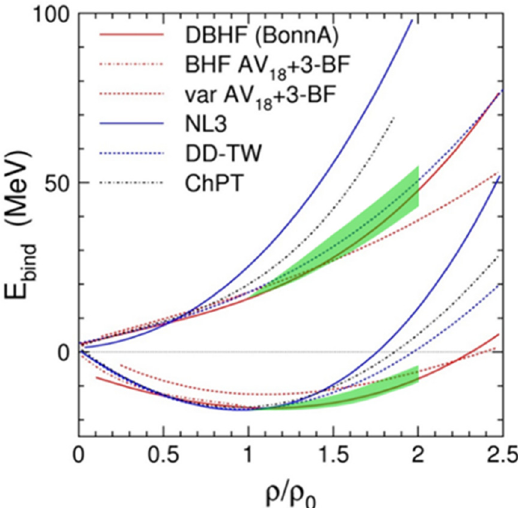
Figure 2. Various equations-of-state for isospin-symmetric nuclear matter (lower curves) and neutron matter (upper curves) as a function of baryon density. Taken from [7]. The green areas are consistent with data taken at GSI [8–13], see text.